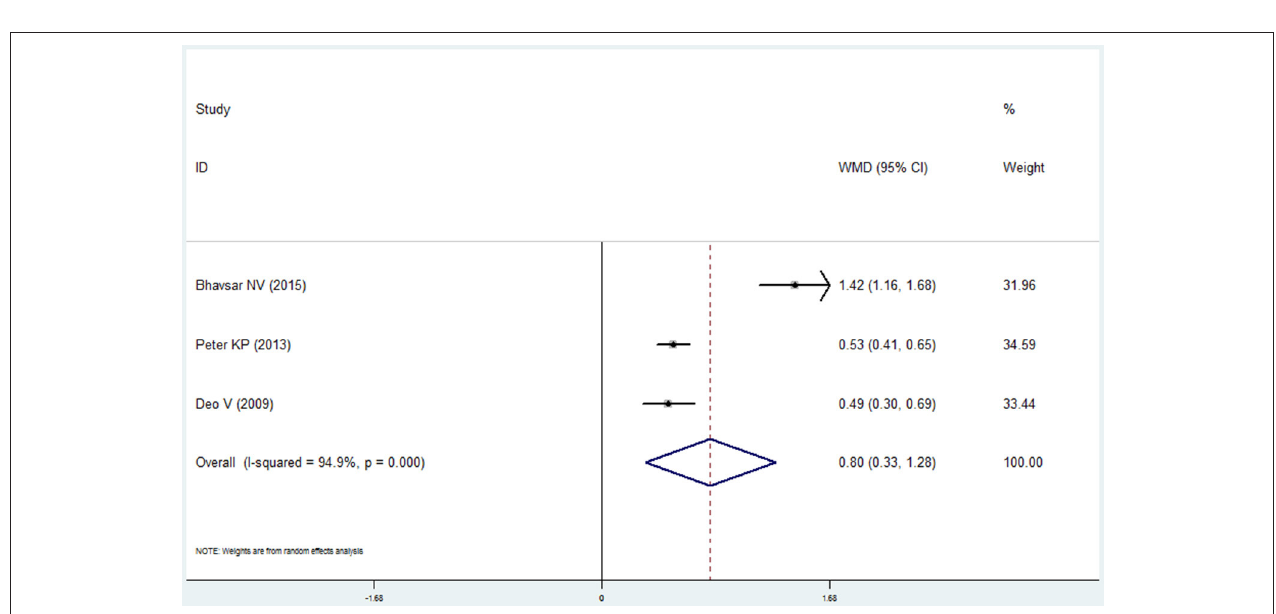
FIGURE 6 | Forest plot of the mean difference in oral hygiene index between the COPD and non-COPD groups.